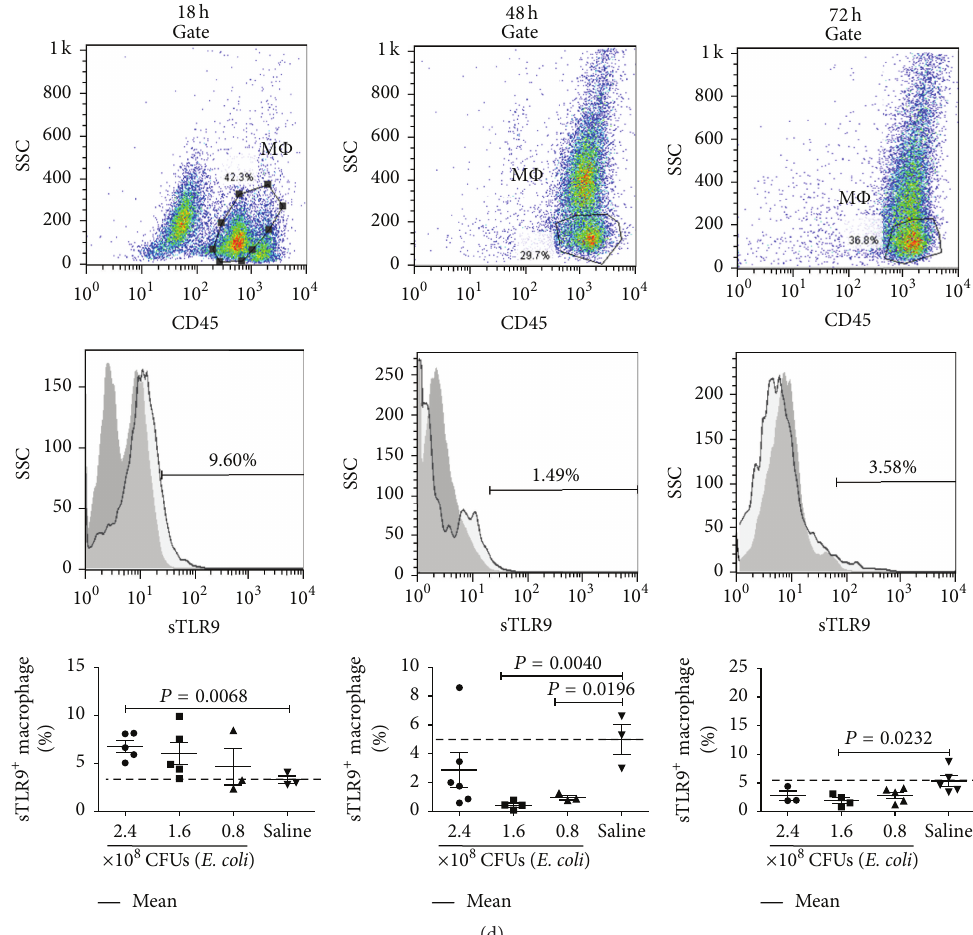
Figure 4: The ratios of sTLR9 + PMNs and macrophages in PLCs from mice infected intraperitoneally with E. coli . ICR mice were infected intraperitoneally with 3 doses of E. coli or received saline and sacrificed at 18, 48, and 72 hours to harvest their PLCs. The PLCs were stained with fluorescence-labeled mAb of anti-CD45, anti-CD11b, and anti-TLR9 followed by detection with flow cytometry. (a) Gates of the PMNs from the CD45 + PLCs followed by gating CD11b + PMNs or CD11b − PMNs from the PMNs. (b) Ratios of sTLR9 + PMNs in CD11b + PMNs. (c) Ratios of sTLR9 + PMNs in CD11b − PMNs. (d) Ratios of sTLR9 + macrophages. Each point represents the data from one